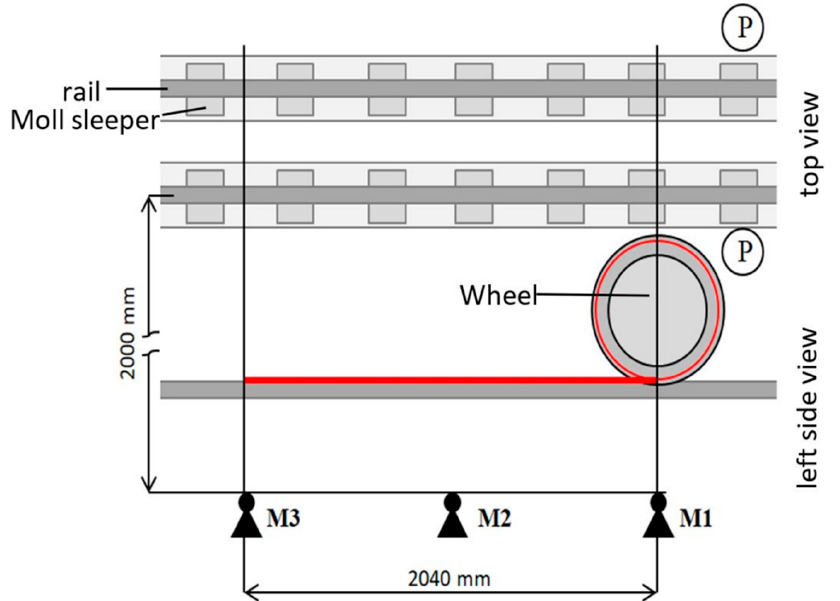
Figure 10. The scheme of measuring positions during acoustic pass-by tests; M1–M3—Microphones, P—Photocells [90].